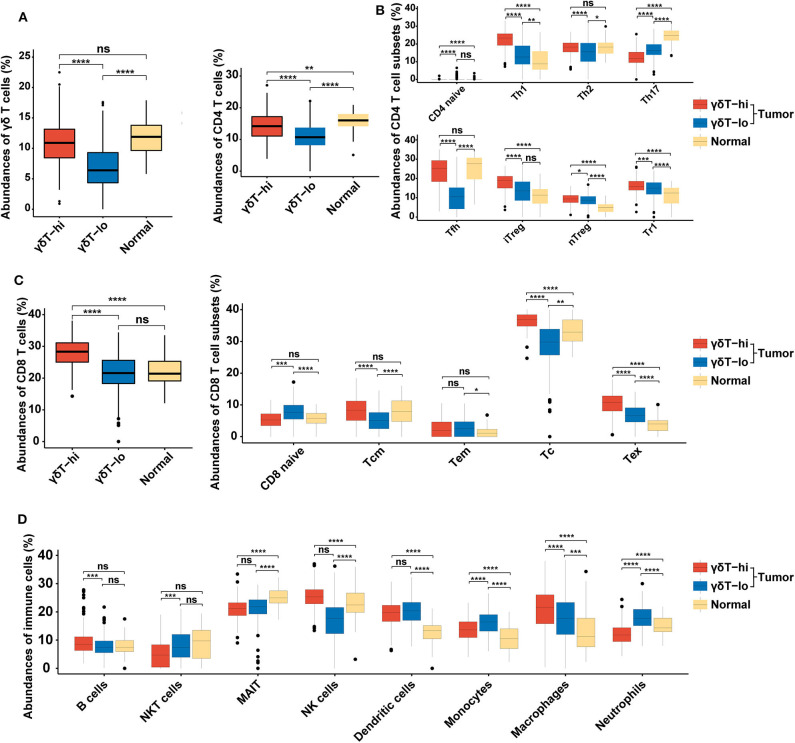
Boxplots showing the relative abundances of 24 cell types among the γδT-hi, γδT-lo and normal groups in HNSCC dataset using ImmuCellAI algorithm. (A) The relative abundances of γδ T cells among the γδT-hi, γδT-lo and normal groups. (B) The relative abundances of CD4+ T cells and their subsets among the γδT-hi, γδT-lo and normal groups. (C) The relative abundances of CD8+ T cells and their subsets among the γδT-hi, γδT-lo and normal groups. (D) The relative proportions of B cells, NKT cells, MAIT, NK cells, dendritic cells, monocytes, macrophages and neutrophils among the γδT-hi, γδT-lo and normal groups. P-values were calculated by student's t-test. CD4 naïve, naïve CD4+ T cells; Th1, T helper cells type 1; Th2, T helper cells type 2; Th17, T helper cells type 17; Tfh, follicular helper T cells; iTreg, induced regulatory T cells; nTreg, natural regulatory T cells; Tr1, type 1 regulatory T cellss; CD8 naïve, naïve CD8+ T cell; Tcm, central memory T cells; Tem, effector memory T cells; Tc, cytotoxic T cells; Tex, exhausted T cells; NKT cells, natural killer T cells; MAIT, mucosal-associated invariant T cells; NK cells, natural killer cells. ns, not significant; *P < 0.05; **P < 0.01; ***P < 0.001; ****P < 0.0001.